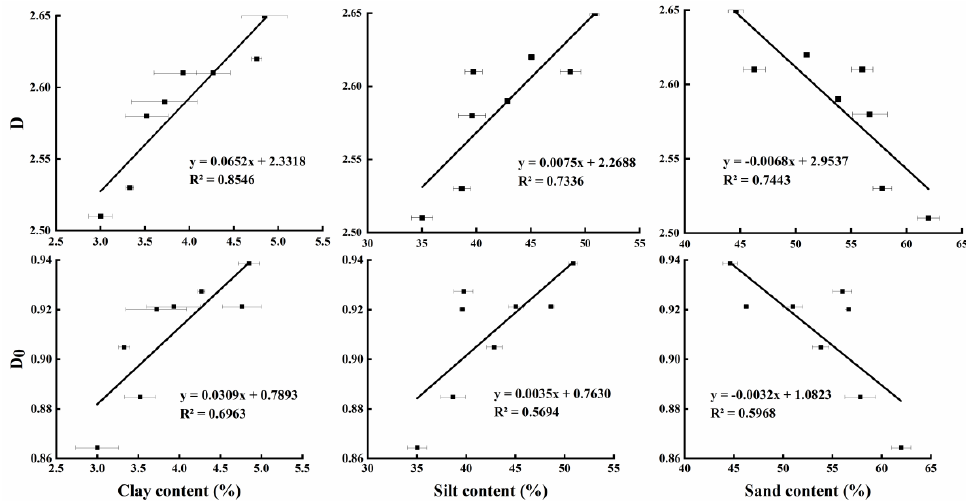
Figure 6. Relations between fractal parameter of D , D 0 and volume percentage of different soil particle sizes under four vegetation restoration types. D is the single fractal dimension, D 0 is the capacity dimension.